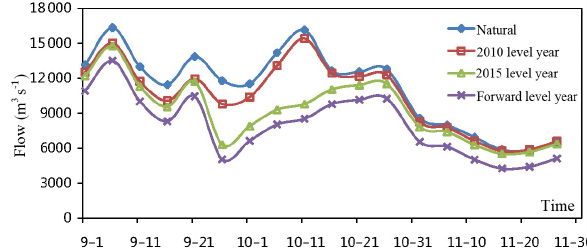
Figure 8. Process of Yichang hydrological station from September to November in especially dry year (2006).